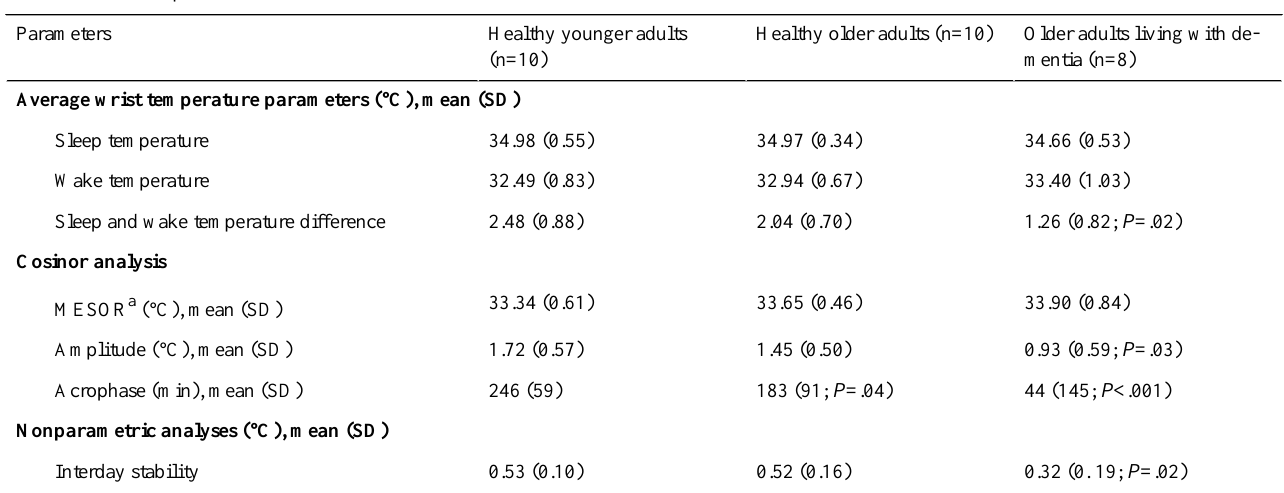
Table 5. Wrist temperature indices.